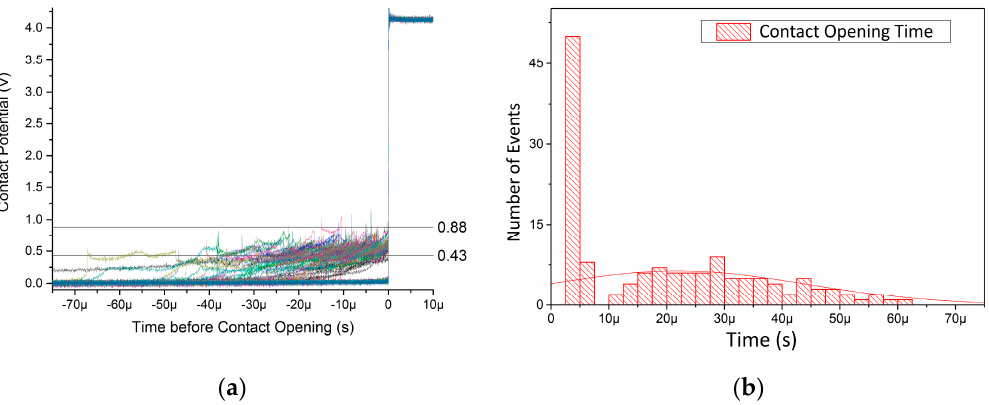
Figure 7. The transient voltage waveforms of 100 consecutive switching cycles ( a ) and a histogram showing the calculated duration of the opening event ( b ). The individual molten metal bridge (MMB) waveforms are highly variable but rise to 0.43 and 0.88 V prior to opening. The delamination event (DE) show no increase in the contact potential until the contact abruptly opens.